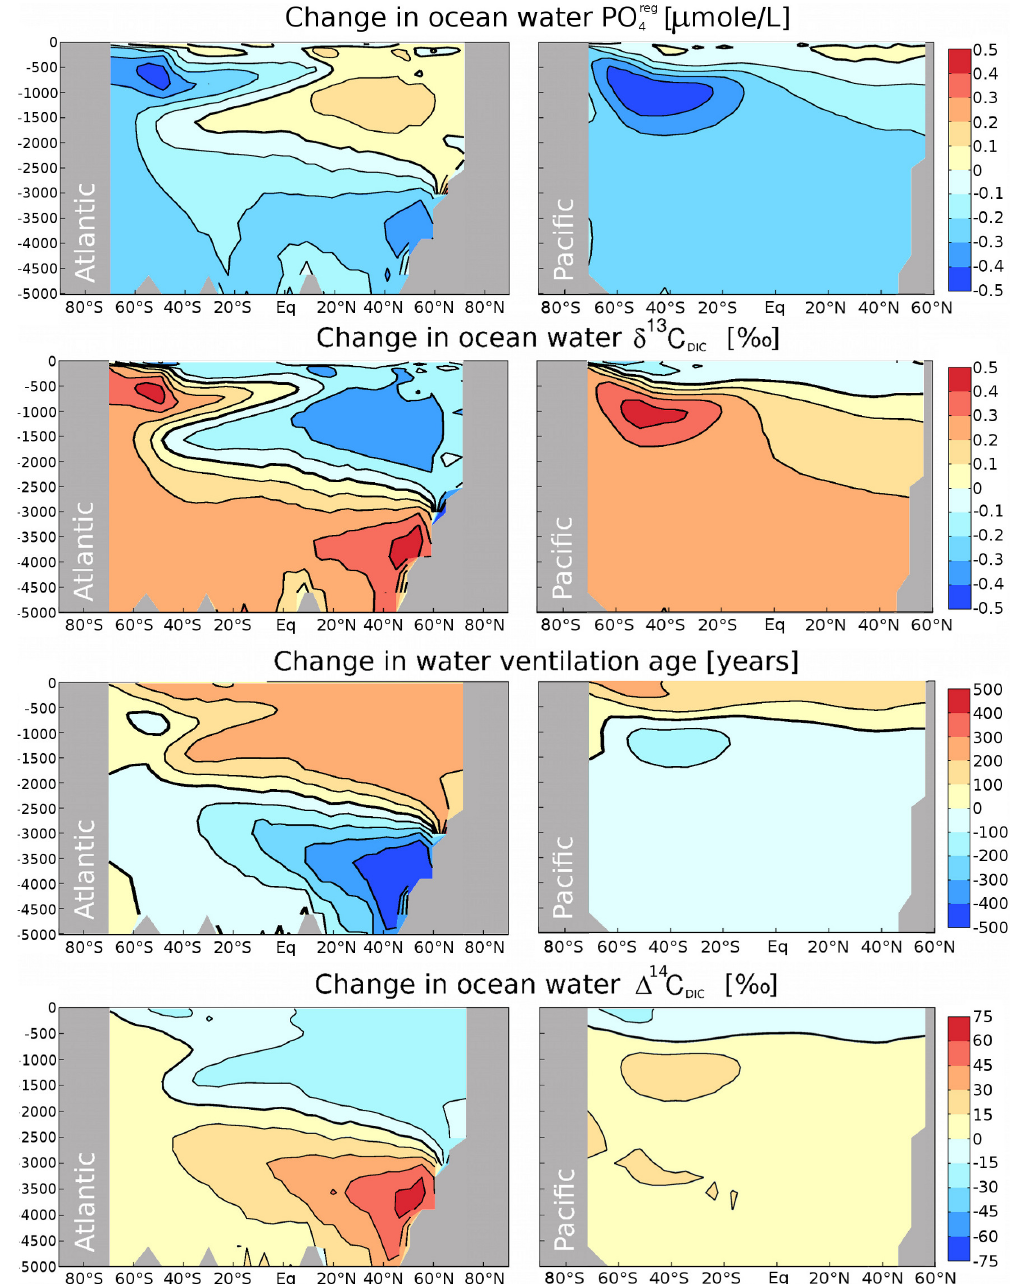
Fig. 9. Model response for δ 13 C DIC , ventilation age and 1 14 C DIC to stimulated deep mixing in the Southern Ocean and to more vigorous and deeper AMOC as a result of a 80%-increase in SO wind stress amplitude. Shown are the simulated differences in Atlantic and Pacifc zonal mean sections at 15ka after the the step-wise perturbation of the model